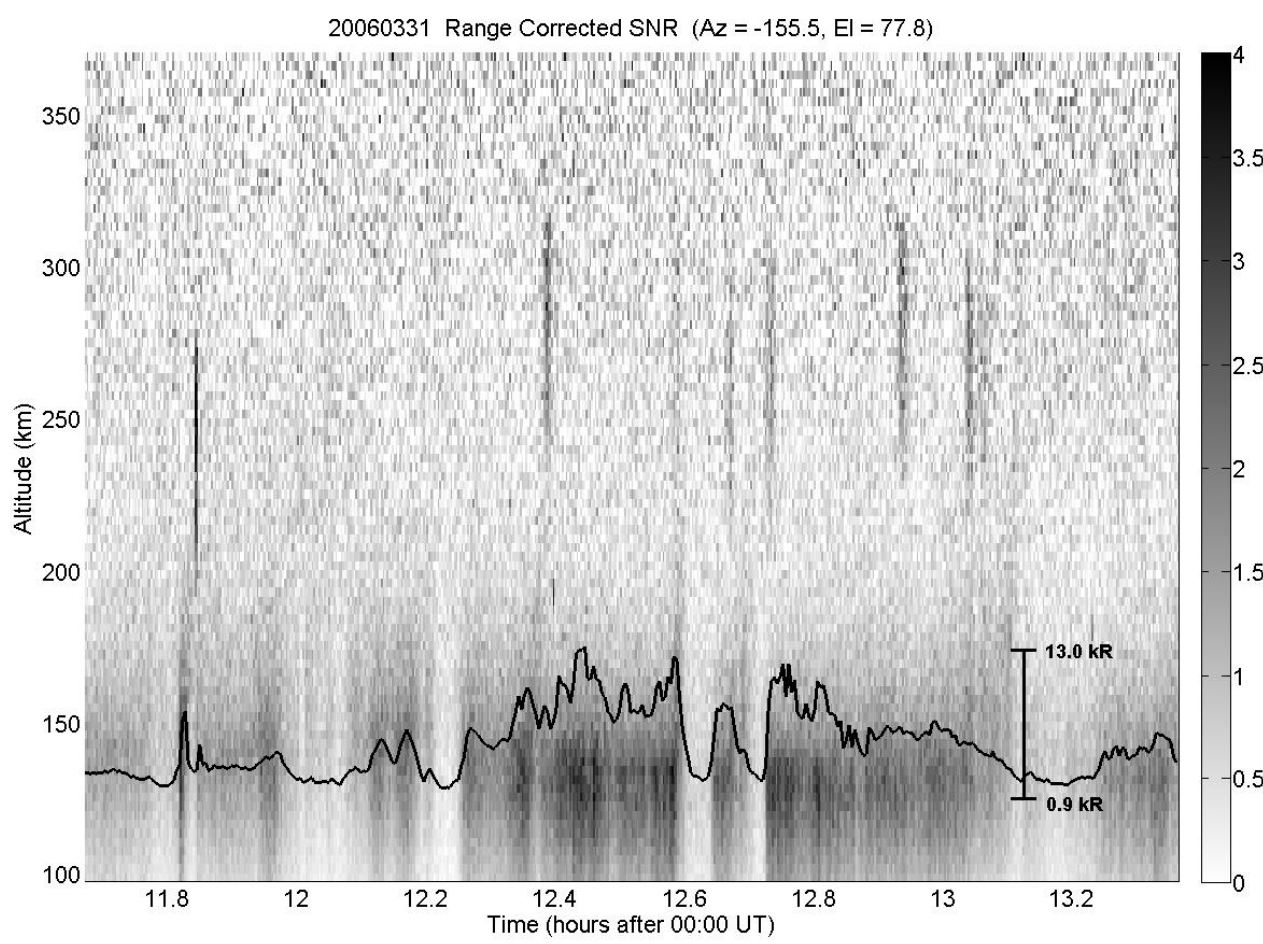
Fig. 2. The range-corrected SNR for 31 March 2006, showing the enhanced backscattered power from the F-region at the 7 times of the NEIAL, and the enhanced E-region from the auroral electron precipitation. The line plot shows the intensity of light from the MSP as a function of time averaged over the region of the radar beam. The intensity varies from 0.9 to